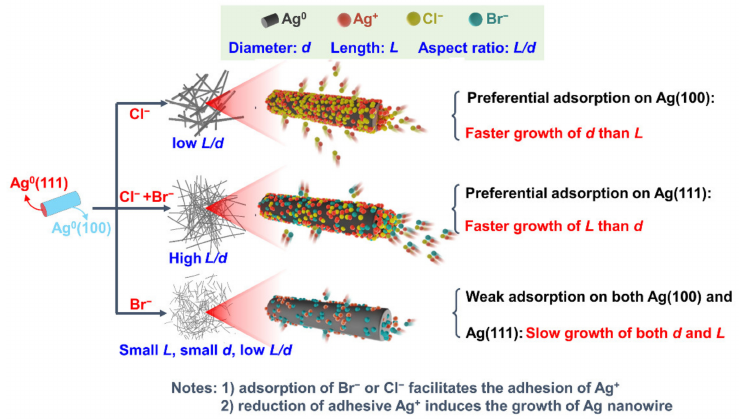
Figure 1. Proposed mechanism for the size regulation of AgNWs by halogen